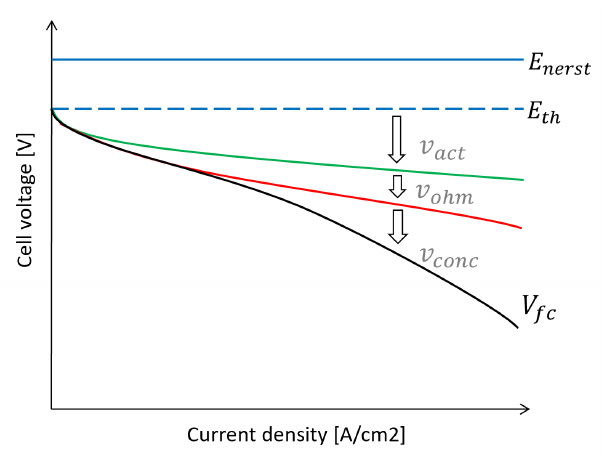
Figure 13. Fuel cell ideal Nerst voltage E nerst , thermodynamic open circuit voltage E th , polarisation curve with actual terminal voltage V fc and voltage drop due to activation V act , ohmic V ohm and concentration loss effects V conc dominant across different parts of the current density